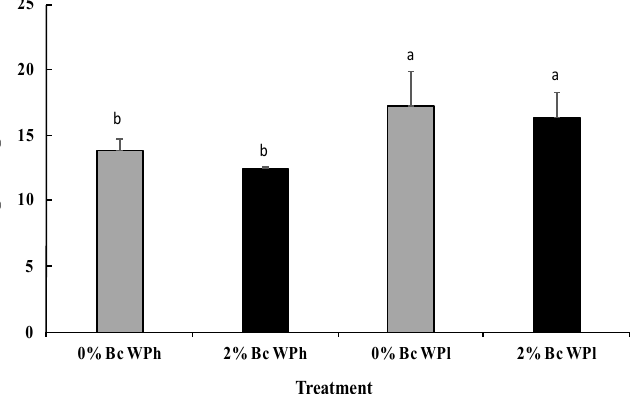
Figure 5. Leave protein content in Medicago ciliaris after 3 weeks of drought treatment. Values represent mean ± SE ( n = 5) and the different letters a and b indicate significant differences between the treatments. Low soil water potential (WPl), high soil water potential (WPh), Biochar (Bc).